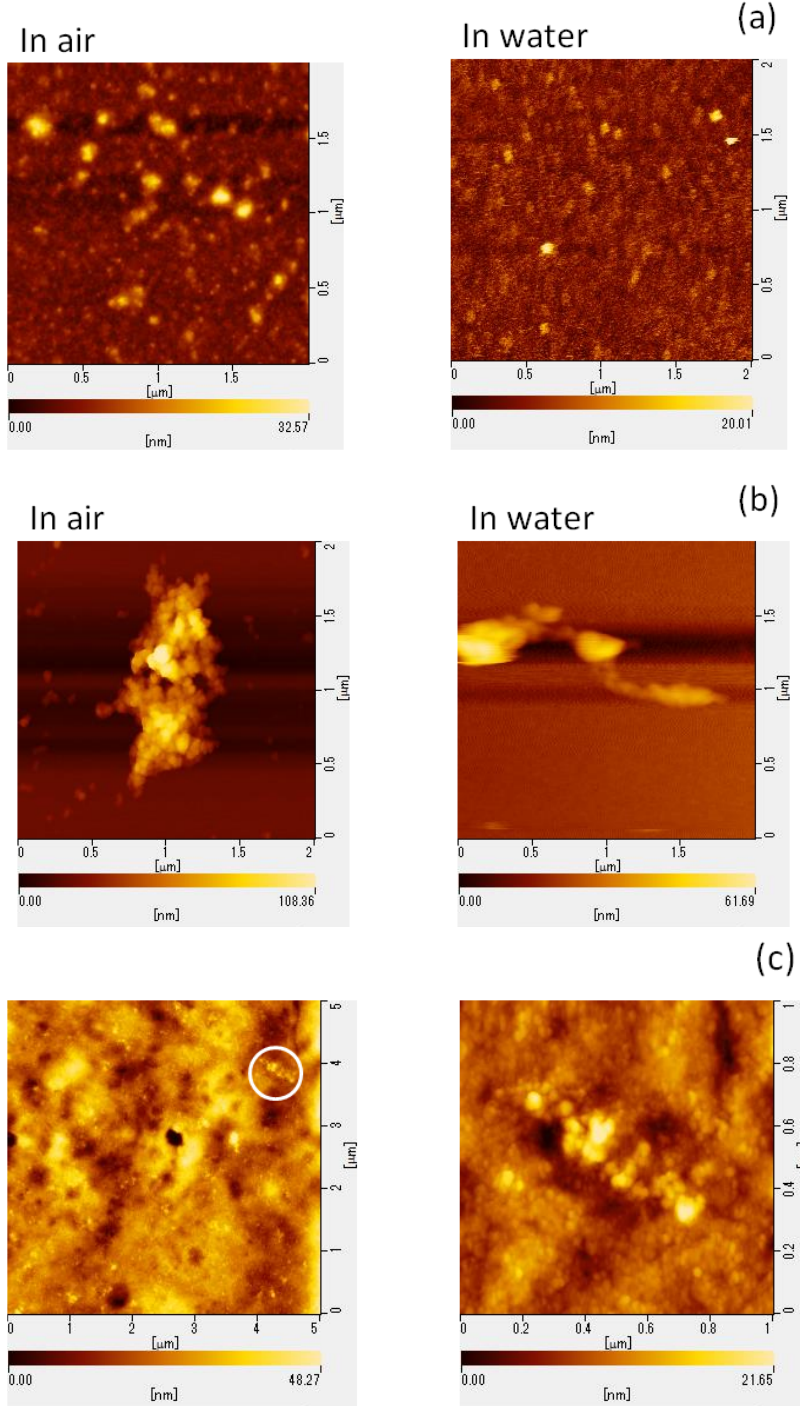
Figure 2. AFM images of MNV. MNV was treated with ( a ) PBS or ( b ) 100 µg/mL GSE for 30 min at room temperature. ( c ) To observe the virus in host cells, GSE-treated MNV suspensions were overlaid on RAW 264.7 cells. In ( c ), the right picture was the magnified image around the circle in the left picture. AFM, atomic force microscopy; MNV, murine norovirus; GSE, grape seed extract. 2.4. Evaluation of the Irreversibility of GSE’s Virucidal Effect in Vivo We assessed whether the virucidal activity of GSE was irreversible by orally admin- istrating MNV inoculated with GSE to mice (1 × 10 6 PFU/mouse). The plaque assay con- firmed that the viral inoculums used in the animal experiment had no infectivity. All mice survived the experiment, and no weight loss or diarrhea was observed during the 21-day experimental period. MNV was detected in the feces of the control group until the 16th post-inoculation day (Figure 3). Viral shedding stopped 1-day post-inoculation in both groups treated with GSE for 10 or 30 min. In the group treated with 50 µg/mL GSE for 10 min, no viral shedding was observed during the 21-day observation period.